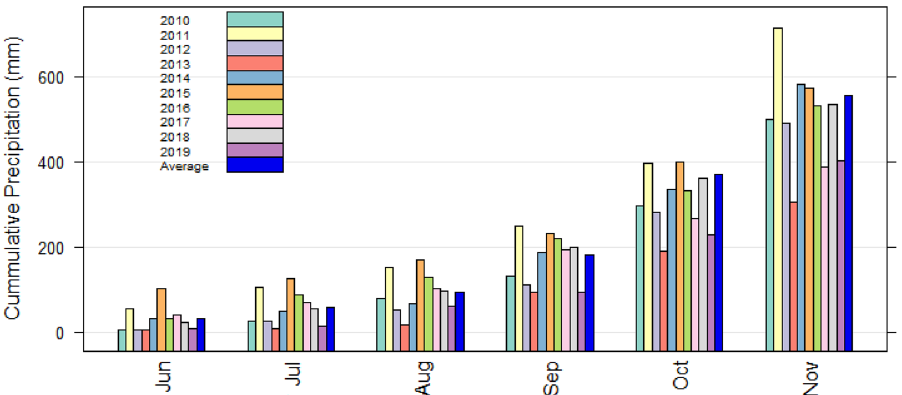
Figure 2. Cumulative precipitation from dry season prior to flowering through flowering, by production year, June–November, 2008 through 2017, corresponding to 2010–2019 production years.